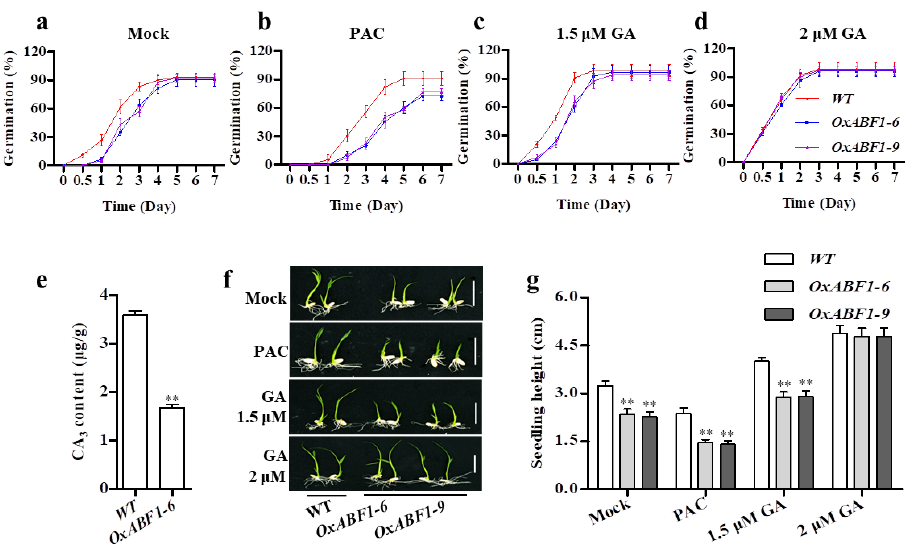
Figure 2. Seed germination characteristics of OsABF1 overexpression lines. ( a – d ) Seed germination time courses of the WT, OxABF1-6 , and OxABF1-9 under mock ( a ), 10 µ M PAC treatment ( b ), 1.5 µ M GA 3 ( c ), and 2 µ M GA 3 ( d ). ( e ) Quantification of GA derivatives of WT and OxABF1-6 seedlings analyzed with liquid chromatography–tandem mass spectrometry. Error bars represent means ± SD ( n = 3), ** indicates statistically significant difference at p < 0.01 compared with Nipponbare in Student’s t -test. ( f , g ) After 7 days seed germination, phenotypes and seedlings height of the WT, OxABF1–6 , and OxABF1–9 under mock, 10 µ M PAC treatment, 1.5 µ M GA 3 , and 2 µ M GA 3 . Error bars represent means ± SD ( n = 20). ** p < 0.01 by Student’s t -test analysis.